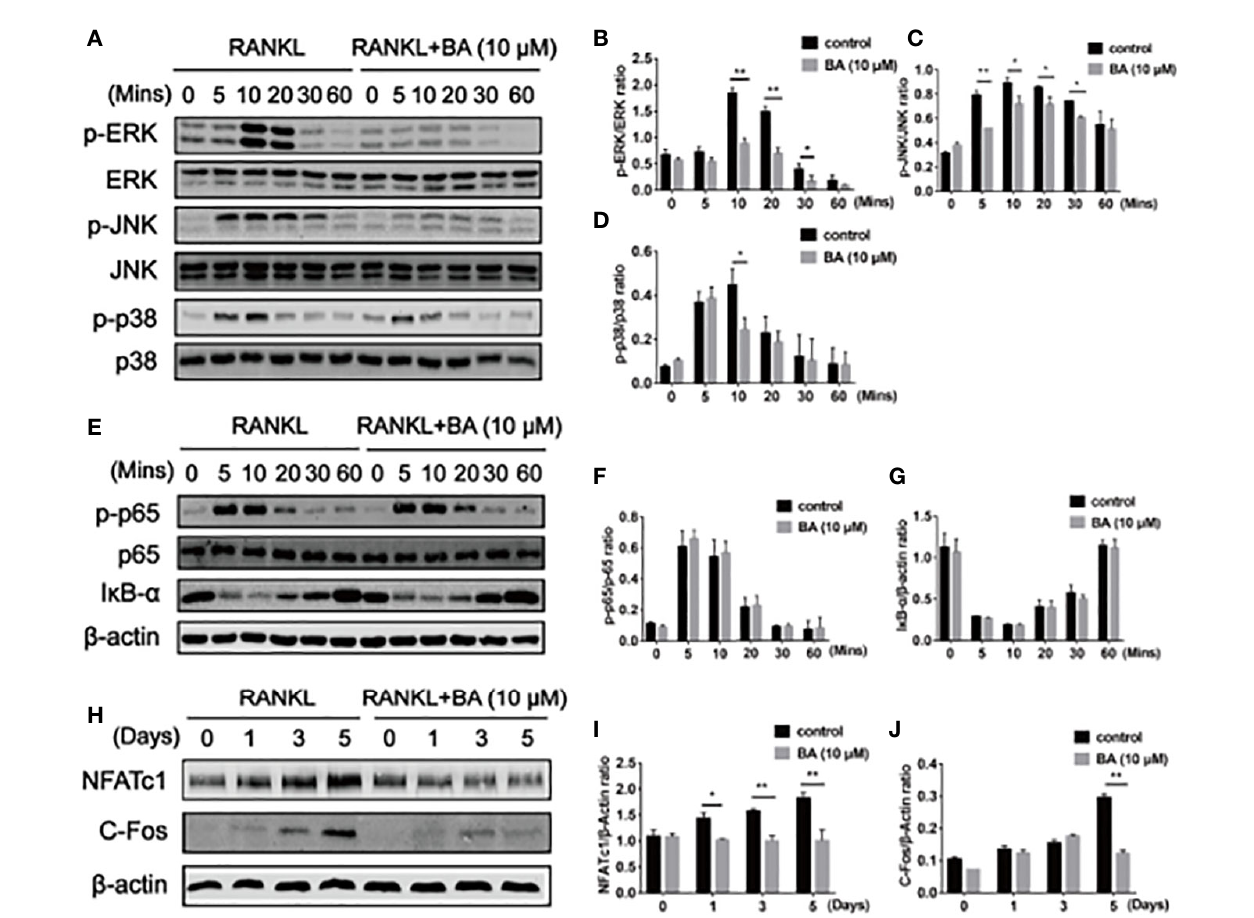
FIGURE 3 | BA suppresses osteoclastogenesis through RANKL-induced signaling pathways. (A) Representative immunoblot images for BA ’ s effects on ERK, JNK and p38 phosphorylation after RANKL induction. BMMs were administered with RANKL for various times in combination or not with 10 m M BA. (B – D) Ratios of phosphorylated ERK, JNK and p38 to total ERK, JNK and p38, respectively (n = 3). (E) Immunoblot images for BA ’ s effects on p65 degradation and I k B- a phosphorylation associated with RANKL at various time points. (F, G) Ratios of phosphorylated p65 and I k B- a to total p65 and b -actin, respectively. (n = 3 per group). (H) Immunoblot images for BA ’ s effects on NFATc1 and c-Fos protein levels. (I, J) Ratios of NFATc1 and c-Fos to b -actin (n = 3/group). Data are mean ± SD. *p <0.05, **p <0.01 vs. RANKL-induced control group (no BA administration). BA, Betulinic